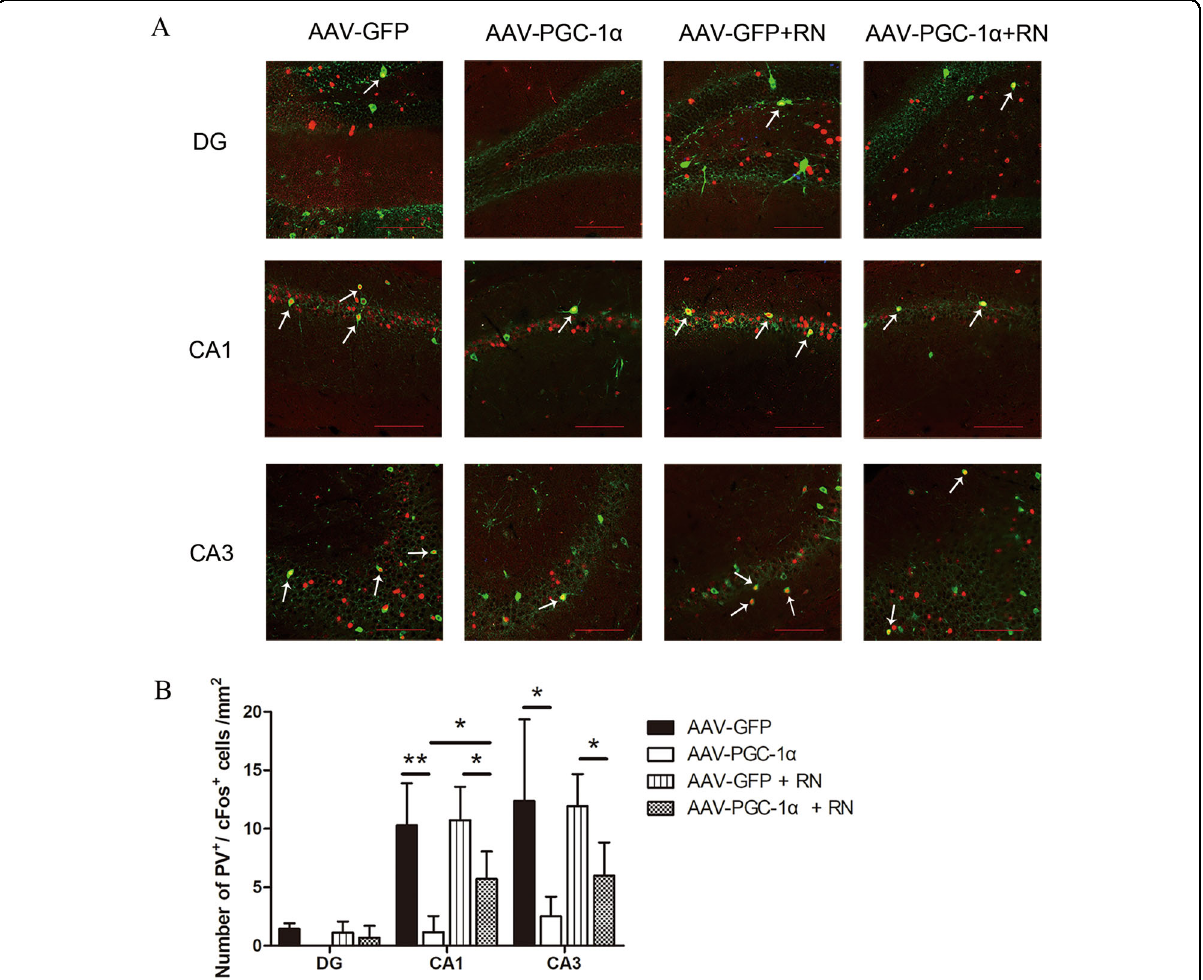
Fig. 4 Comparisons of the cFos + /PV + cells in the DG, CA1, and CA3 sub fi elds of the hippocampus of the mice in different groups. A Representative pictures of immuno fl uorescence staining with anti-PV antibody and anti-cFos antibody in the hippocampus in the four groups. The white arrows show the cFos + /PV + cells. PV: green, c-Fos: red. Scale bar = 100 μ m. B Quanti fi cation of the cFos/PV cell number in the hippocampus in the AAV-GFP group ( n = 4), AAV-PGC-1 α group ( n = 5), AAV-GFP + RN group ( n = 4) and AAV-PGC-1 α + RN group ( n = 5) of mice after immuno fl uorescence staining (mean ± SD). * indicates p < 0.05, and ** indicates p <